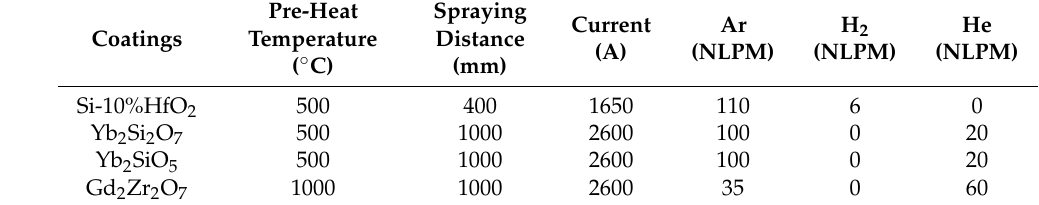
Table 1. Process parameters of PS-PVD for each coating.